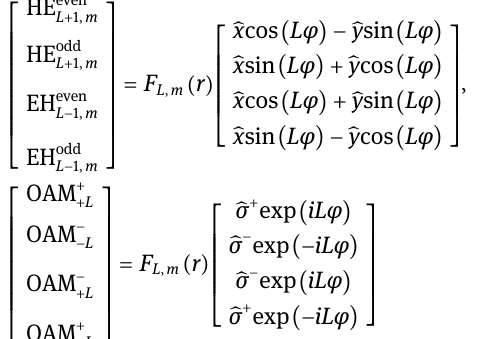
for Spin – Orbit aligned (SOa) modes (and the 2 , 1